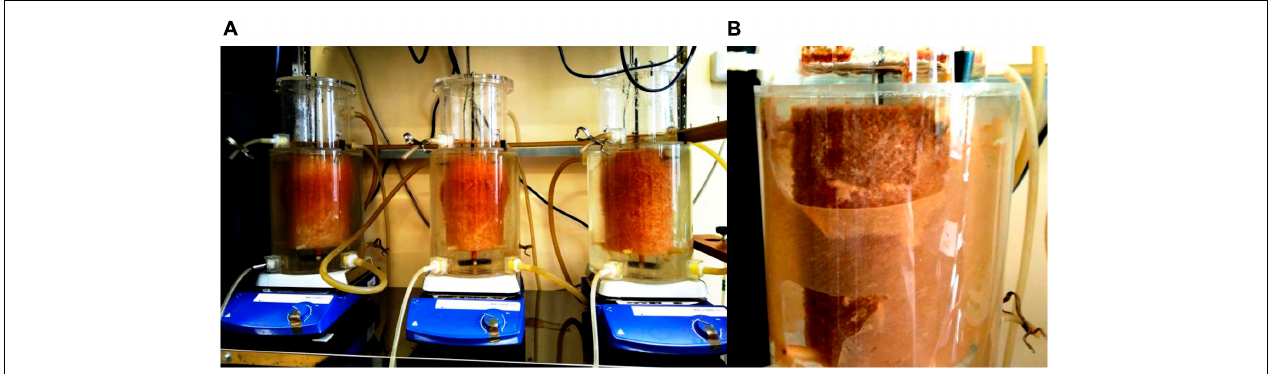
FIGURE 1 | A setup configuration 3 weeks after a start-up (A) and two types of the activated sludge biofilms: on the carrier (carrier) and the inner part of the walls of the reactor (glass) in the formate reactor during the first run (107th day) (B) .